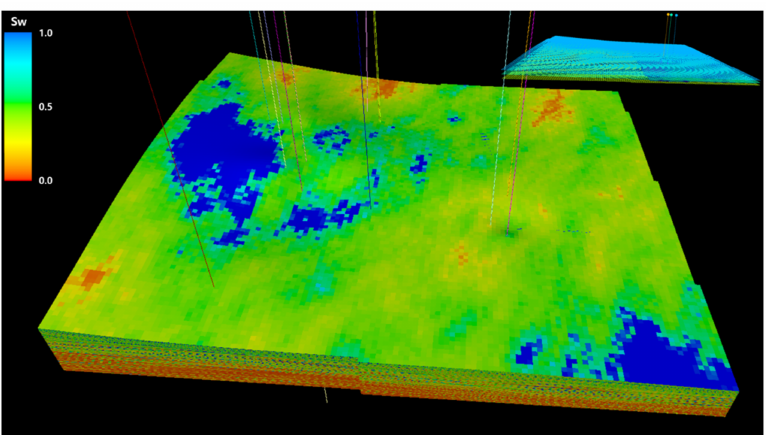
Figure 2. Geology and geophysics model of the Brushy Canyon formation. The color indicates the water saturation